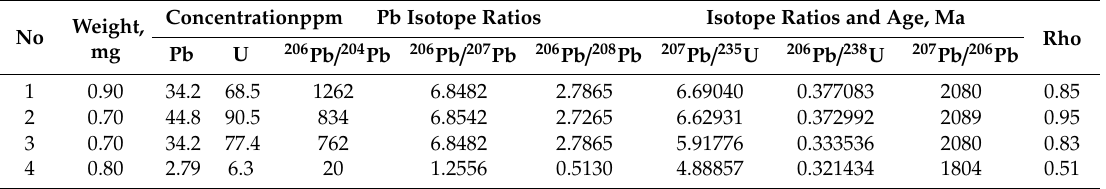
Figure 8. U–Pb plot with concordia on zircon (orange ellipses, 1–3) and rutile (yellow ellipse, 4) from a hornblendite dyke in the Pados-Tundra complex (sample Р-3).